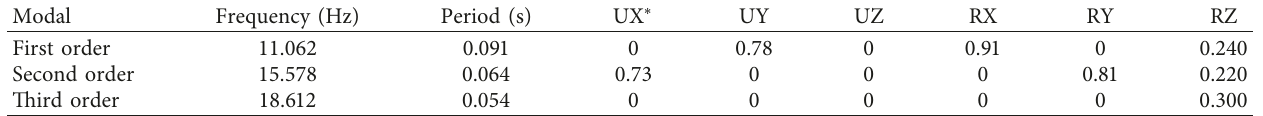
Figure 21: Vibration modes obtained with the forced vibration method and finite element method. (a) First order in X direction. (b) Second order in X direction. (c) First order in Y direction. (d) Second order in Y direction. Table 5: Participation mass ratio for different modals.